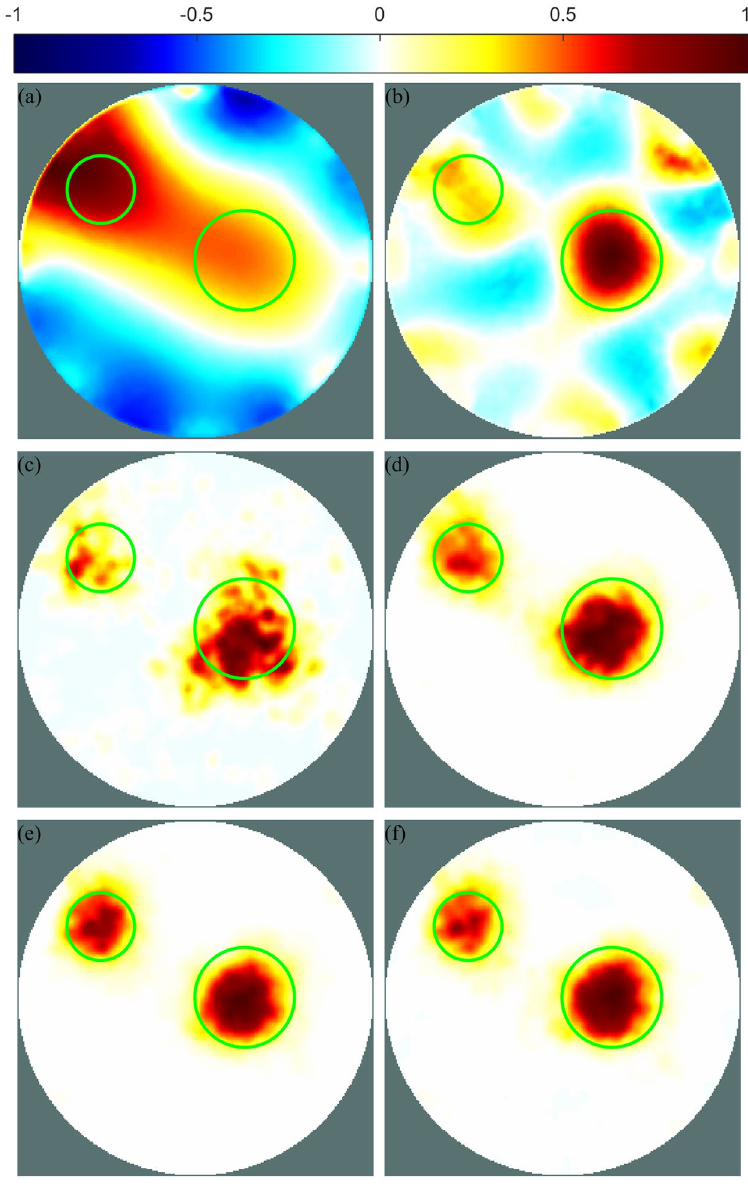
Figure 2. Cross-section view of EIT reconstructions from phantom data with different methods: ( a ) the one- step GN, ( b ) the PDIPM, ( c ) an ANN as inverse solver trained without considering noise, ( d ) the proposed post-processing method and an ANN trained without considering noise, ( e ) an ANN as inverse solver trained with noisy data and ( f ) the proposed post-processing method and an ANN trained with noisy data. Green circles show the location of the targets. The bar at top is the normalised conductivity